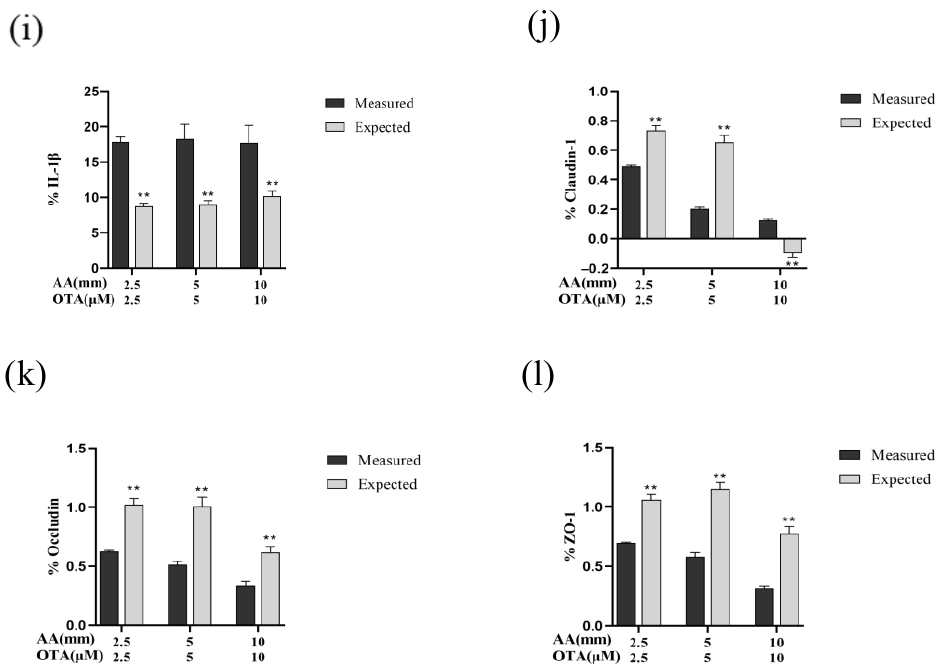
Figure 8. Interactive cytotoxic effects of AA and OTA collectively in the Caco-2 cells after 24 h ( a – l ). Data are presented as a percentage of unprocessed controls for each parameter. (*) p < 0.05; (**) p < 0.01. And ns means no significant difference.